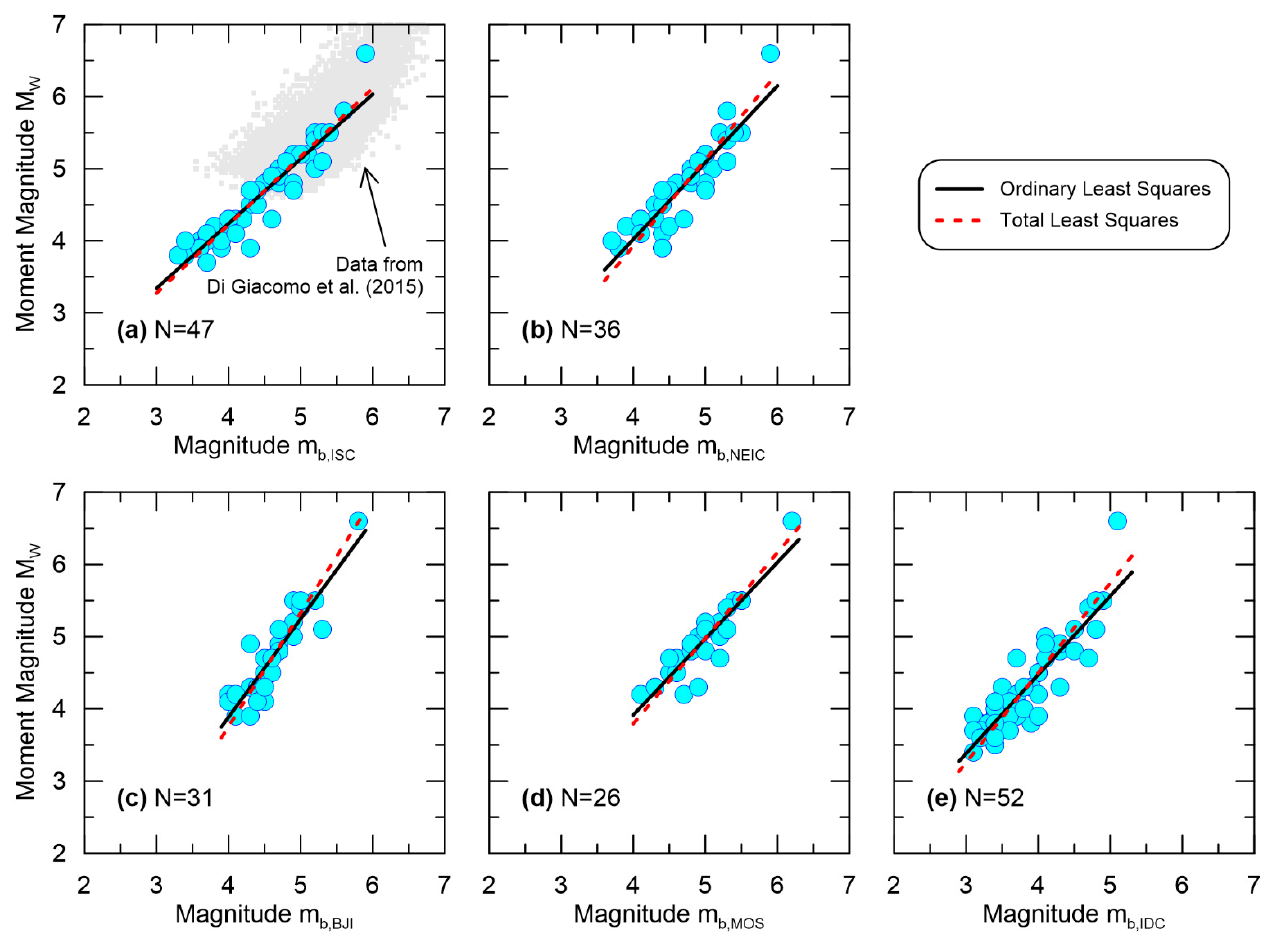
Figure 3. Relationships between M w against m b from ( a ) ISC, ( b ) NEIC, ( c ) BJI, ( d ) MOS, and ( e ) IDC. The solid and dashed lines represent the regression type as indicated in the graph. N is the number of data points used for regression. Data by Di Giacomo et al. (2015) from a larger earthquake compilation related to M w versus m b is shown in gray symbols in the background for comparison [19].